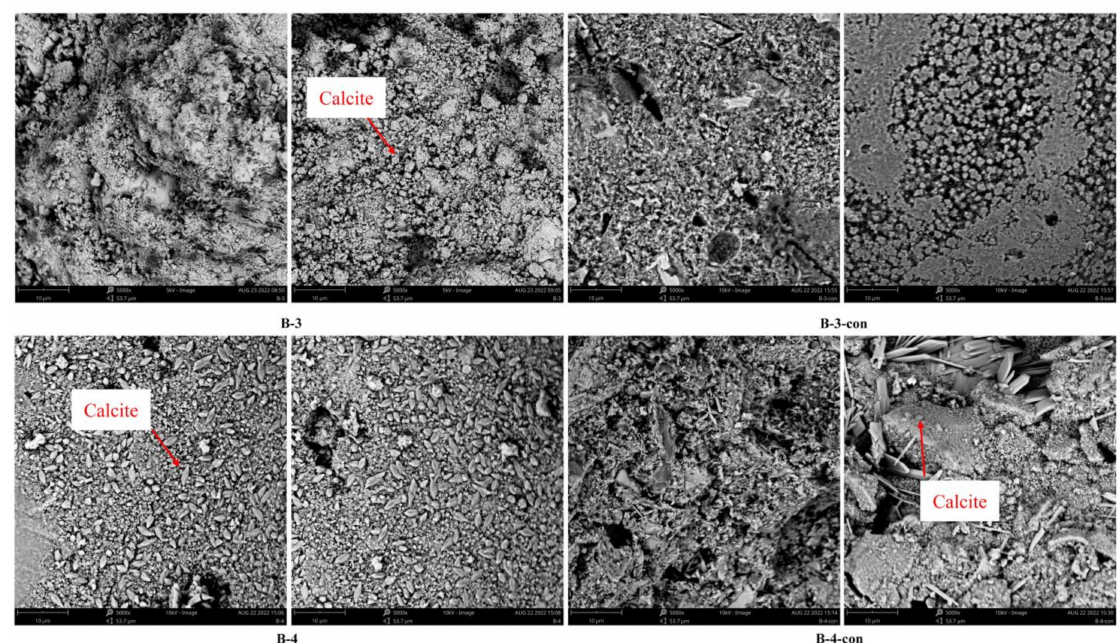
Figure 15. SEM observation in samples of B-3 and B-4